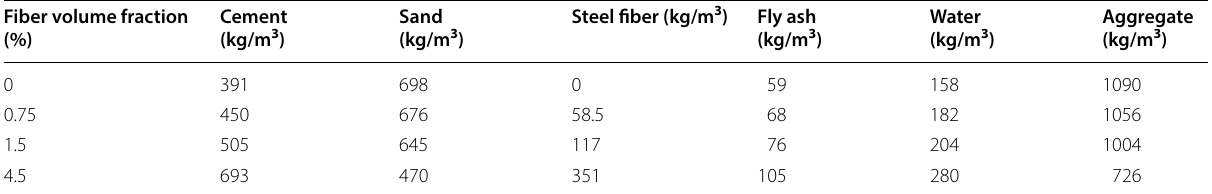
Table 1 Mix proportions design of SFRC.